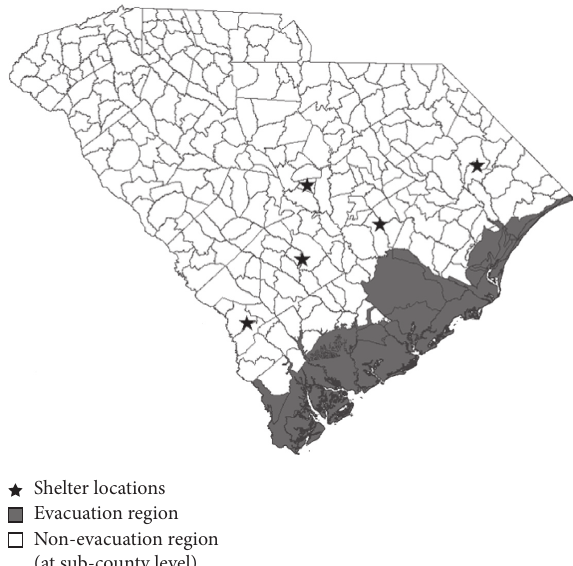
Figure 2: South Carolina evacuation region map layers’ source [48, 53].